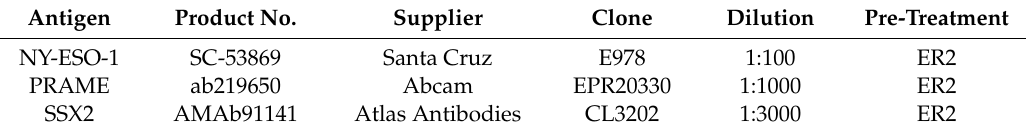
Table 4. Antibodies used for immunohistochemistry staining. ER2: epitope retrieval solution 2. Antigen Product